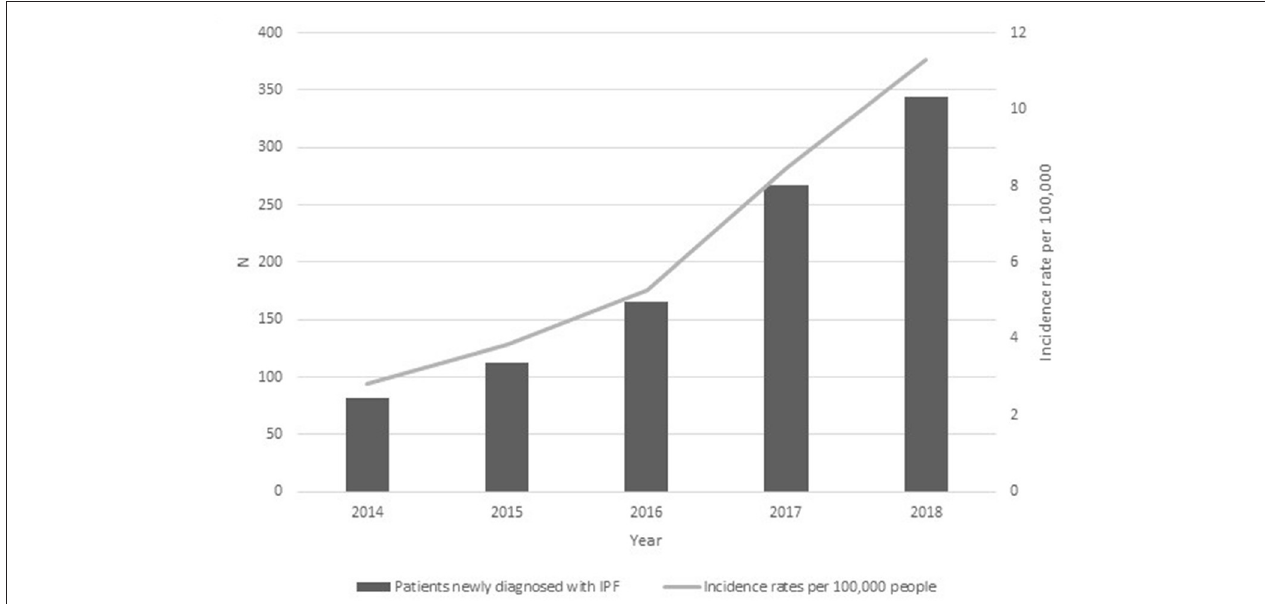
FIGURE 1 | Patients with confirmed diagnosis of IPF in the Lazio region from 2014 to 2018. Absolute numbers and incidence rates per 100,000 people ( > 45 years of age).